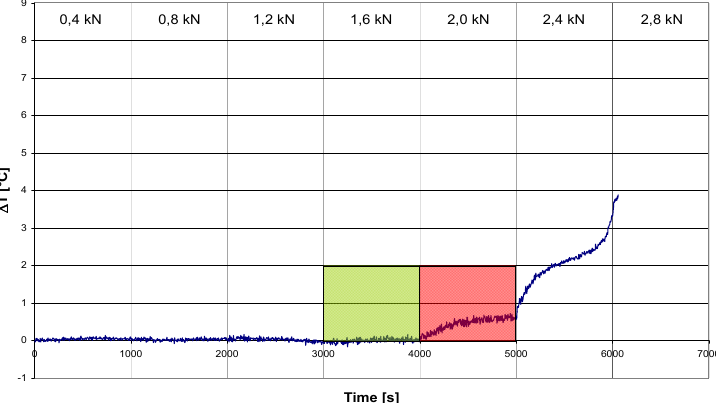
Figura 12: Valori di carico e variazione termica accettabili (verde) e non accettabili